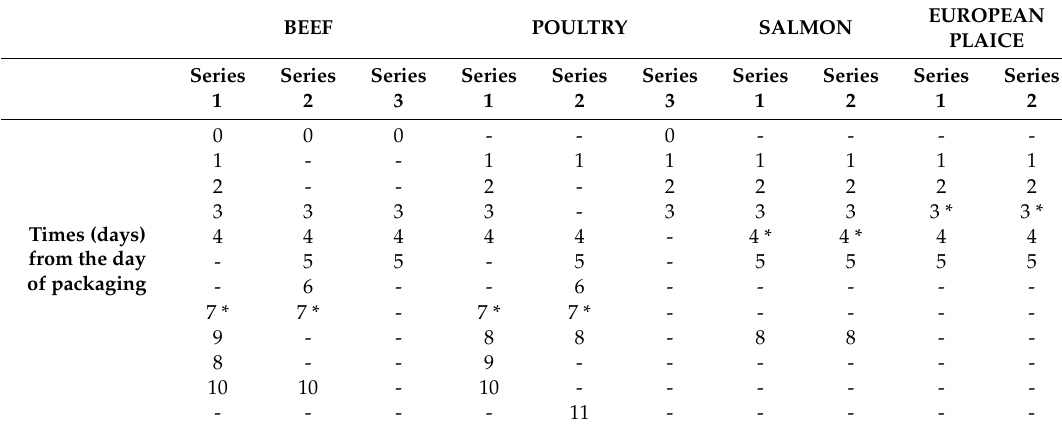
Table 2. Experimental